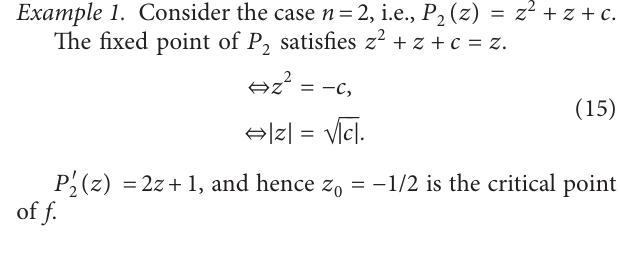
( z ) � z 3 + z + c is connected where 3 ) 3